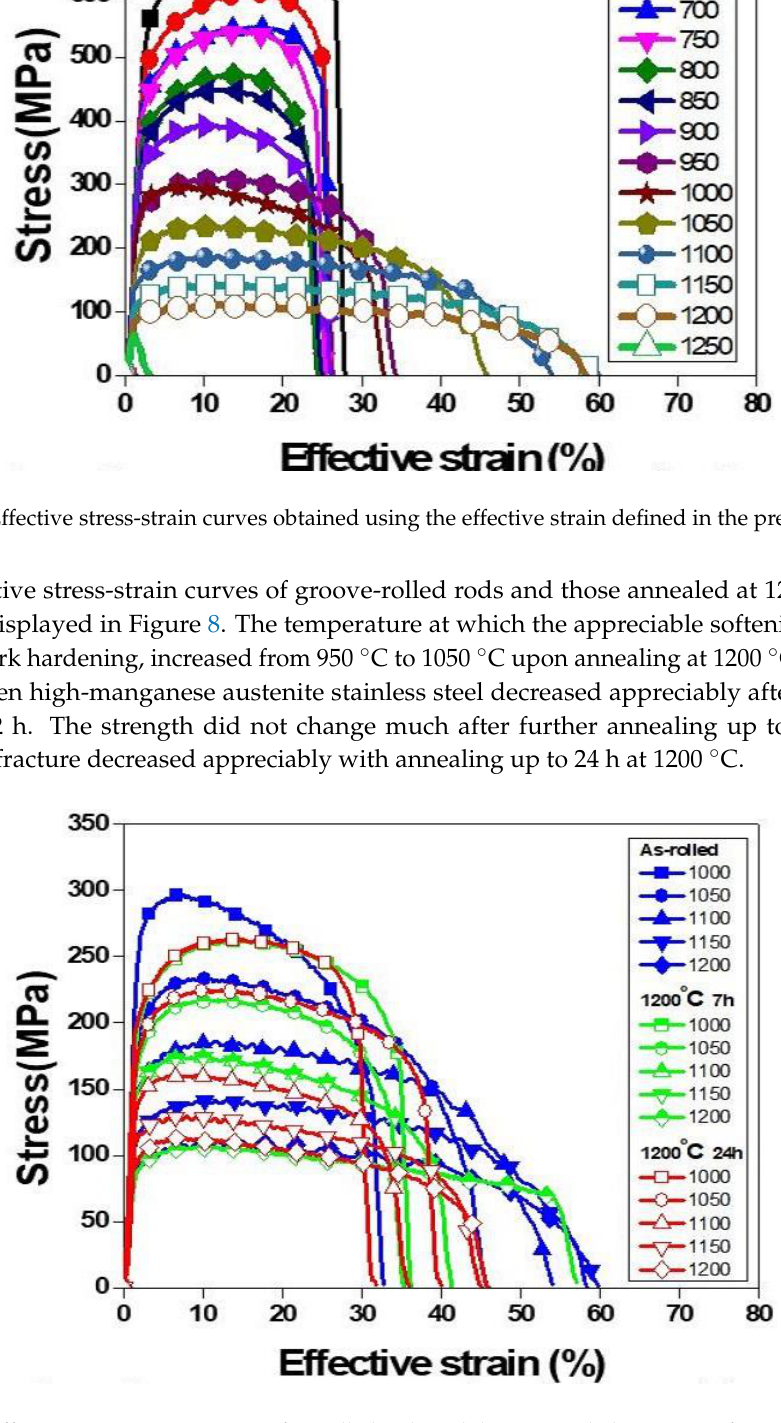
Figure 8. Effective stress-strain curves of as-rolled rods and those annealed at 1200 °C for 12 h and 24 h.